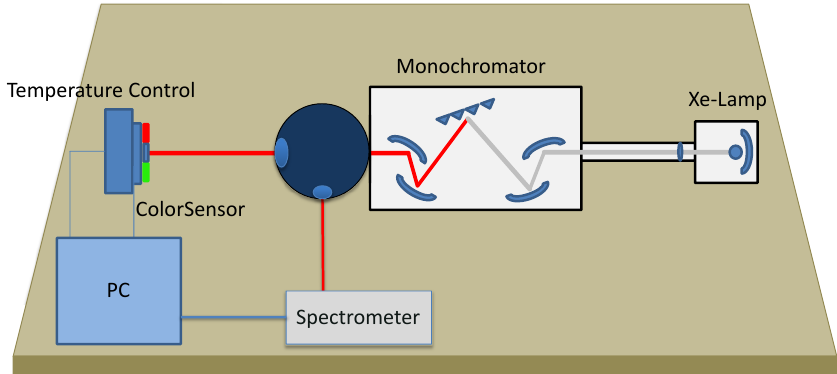
Figure 3. Schematic illustration of a monochromator setup used for determining the spectral sensitiv- ity curves R ( λ ) , G ( λ ) , and B ( λ ) of an RGB color